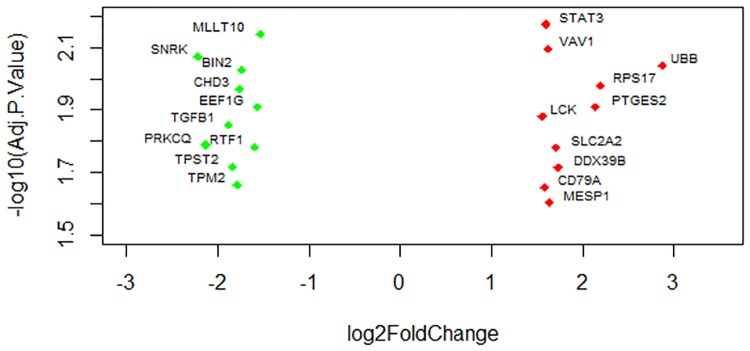
Volcano plot showing the most significantly altered genes at day one post vaccination.The picture demonstrates the range of fold changes of most significantly altered transcripts in connection to innate immune response in PBMCs.